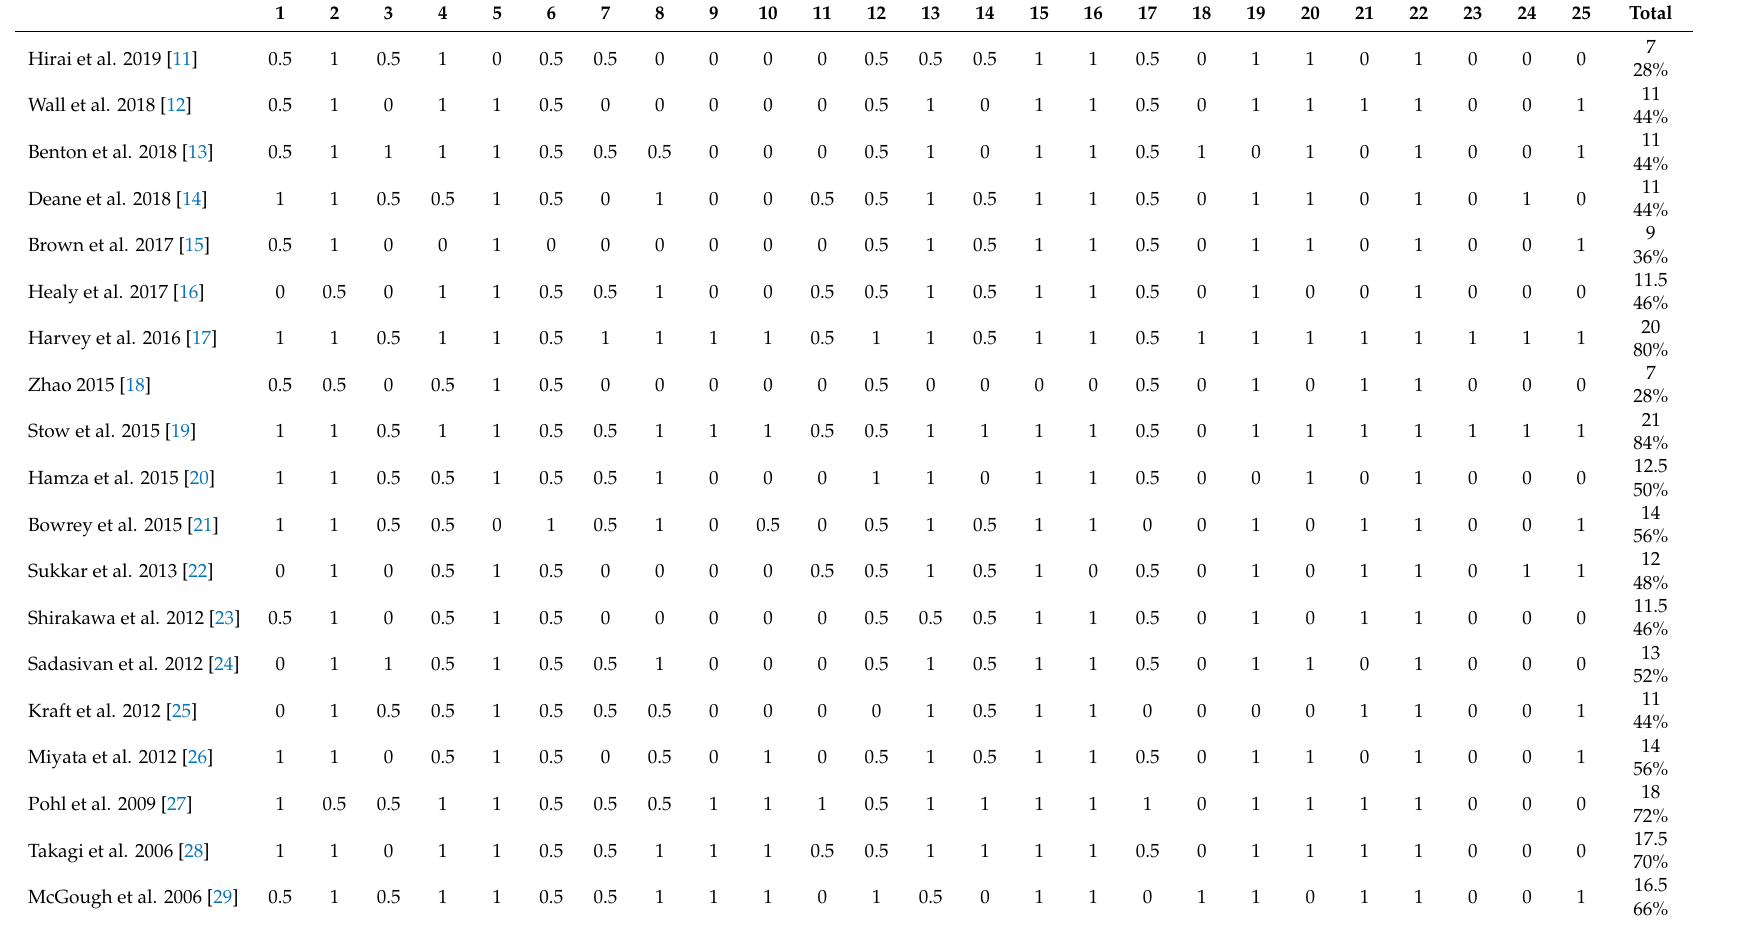
Table 2. Assessment of study quality according to the 25-item CONSORT